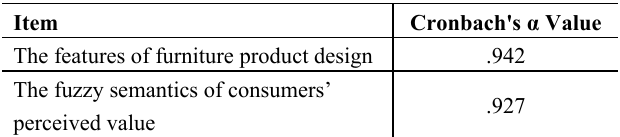
Table 4: Questionnaire reliability analysis